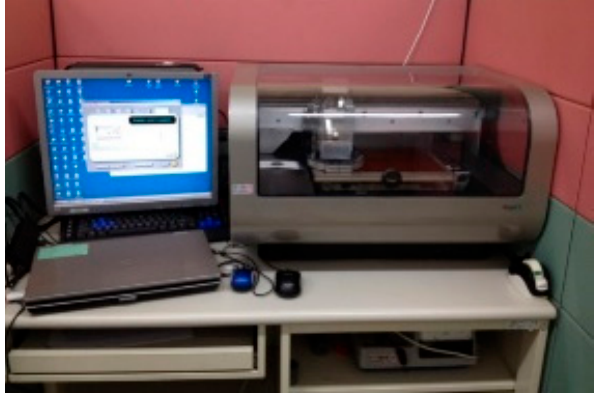
Figure 6. Silver nanoparticles ink jet printer.